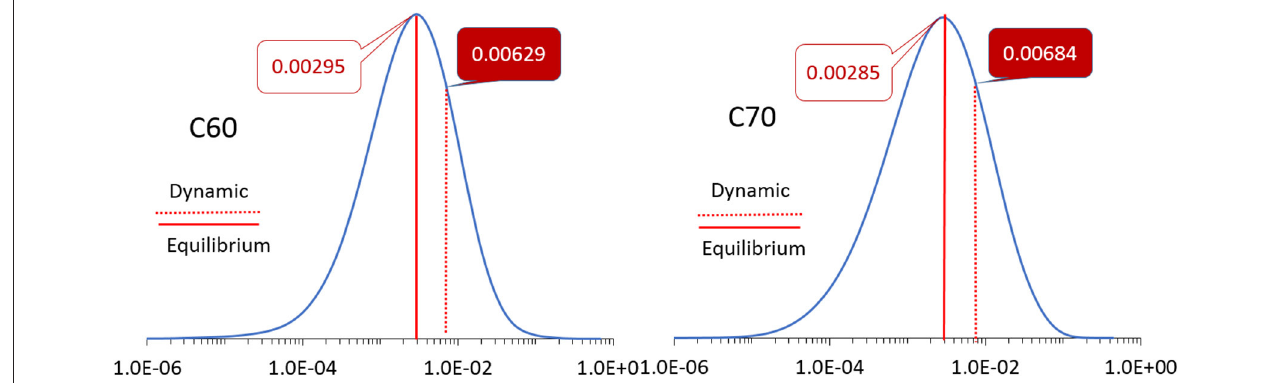
FIGURE 3 | The distributions of the values of the exponent in the Marcus equation (Equation 2) for C60 (left) and C70 (right) . The values at the equilibrium geometry and expectation values over molecular dynamics trajectories are indicated by solid and dotted red lines, respectively, with corresponding numbers as inserts. Note the logarithmic scale of the abscissa.